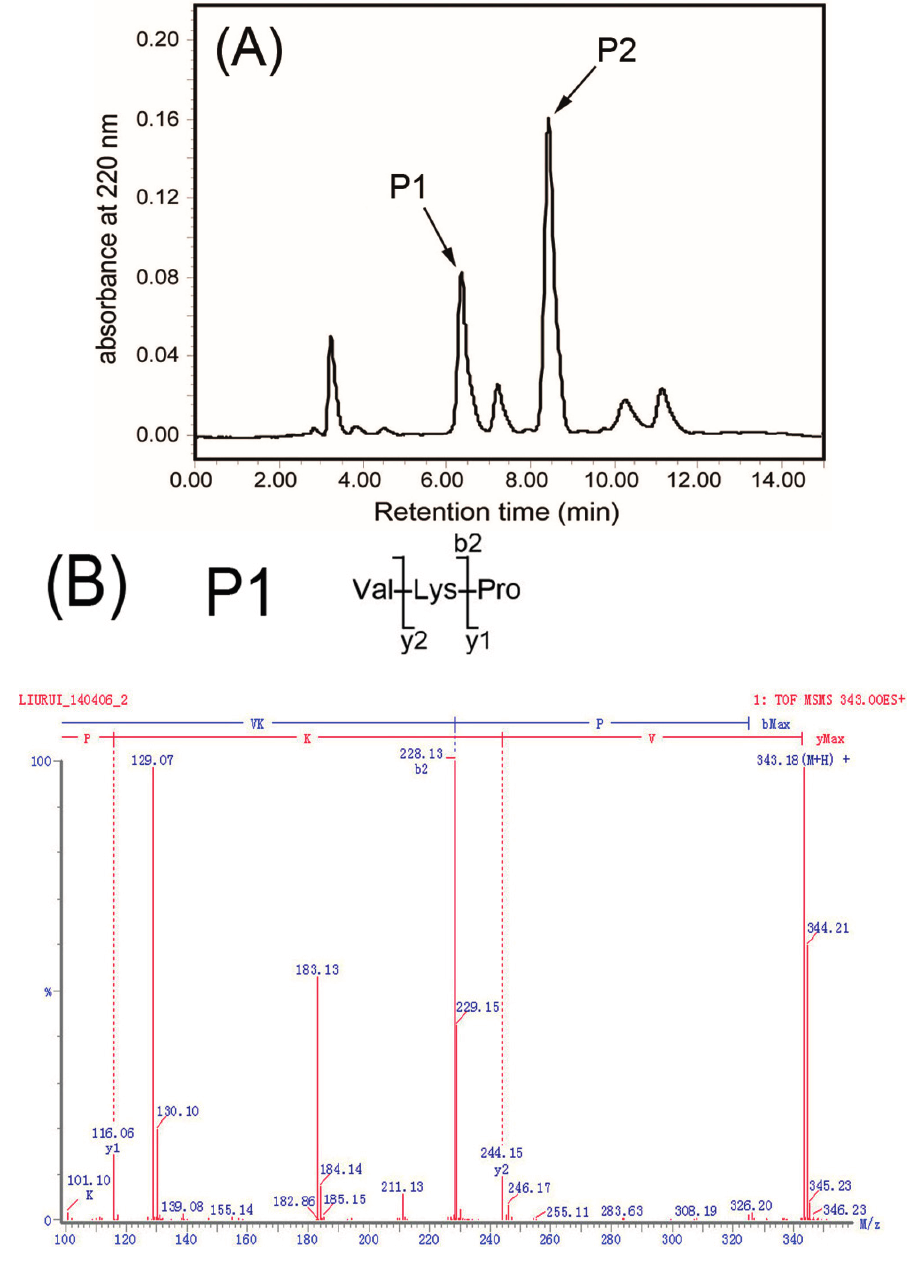
Figure 2. ( A ) Reversed-phase HPLC separation pattern on a C column of the active fraction 18 FI from Figure 1D. The gradient conditions were: 0–1.5 min, 2% methanol; 1.5–10 min, linear from 2% to 30% methanol. Elutions were performed at a flow rate of 0.5 mL/min using a UV detector at 220 nm. ( B ) Identification of molecular mass and amino acid sequences of P1, MS/MS experiments were performed on ESI Q-TOF